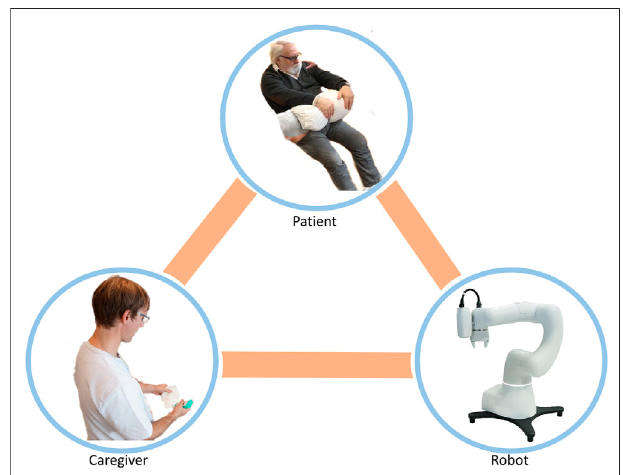
FIGURE 3 | Scenario where the patient uses the robot as an assistance to get up without the help of the nurse.